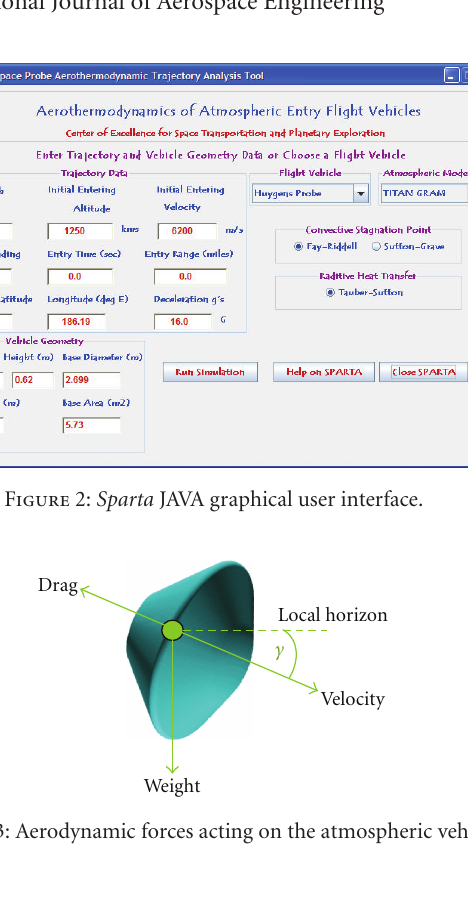
to calculate pressure, density, temperature, Reynolds num- ber, and speed of sound as a function of altitude. GRAM